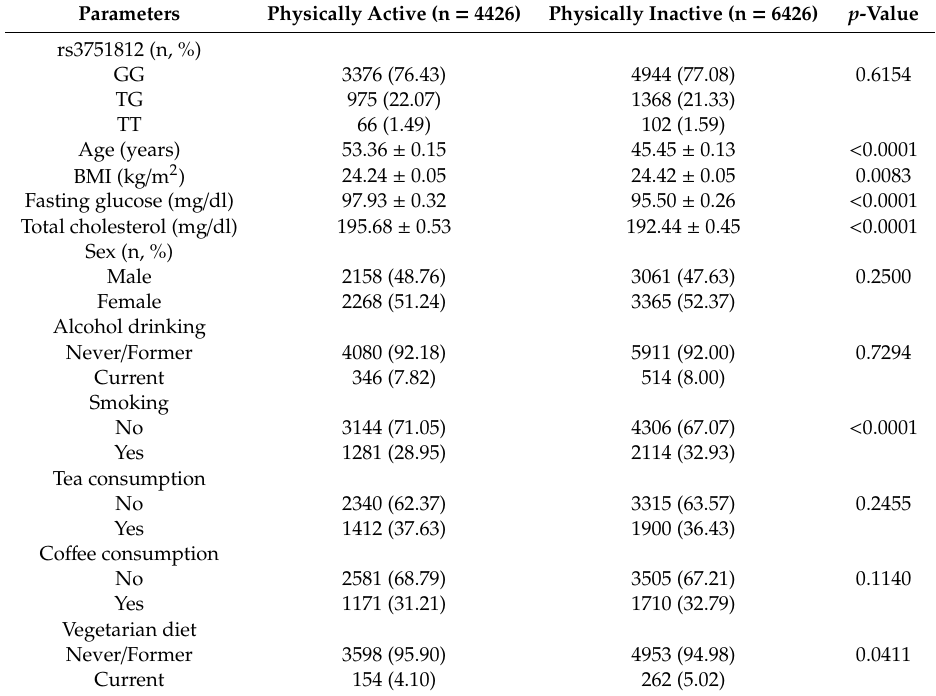
Table 2. Demographic and lifestyle variables of study participants under stratification based on physical